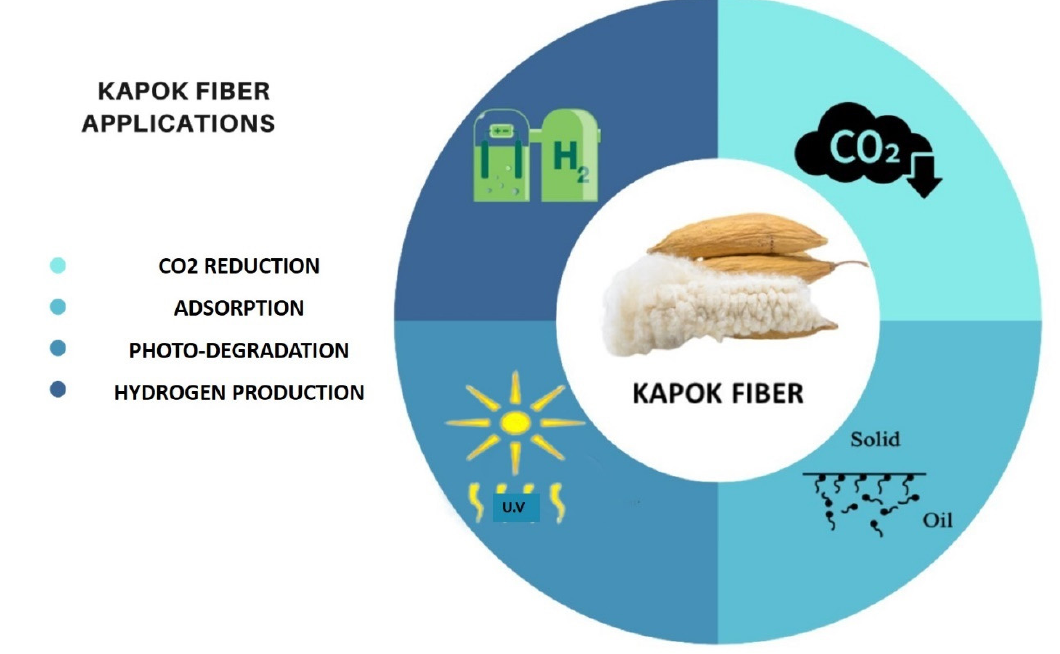
Figure 11. Several applications of Kapok Fiber.